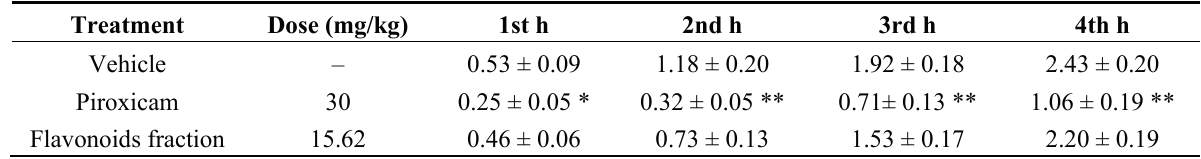
Table 2. Effects of administration of flavonoid fraction from Davilla elliptica leaves via the intraperitoneal route on carrageenan-induced rat paw oedema. Treatment Dose (mg/kg) 1st h 2nd h 3rd h 4th h Vehicle – 0.53 ± 0.09 1.18 ± 0.20 1.92 ± 0.18 2.43 ± 0.20 Piroxicam 30 0.25 ± 0.05 * 0.32 ± 0.05 ** 0.71± 0.13 ** 1.06 ± 0.19 ** Flavonoids fraction 15.62 0.46 ± 0.06 0.73 ± 0.13 1.53 ± 0.17 2.20 ± 0.19